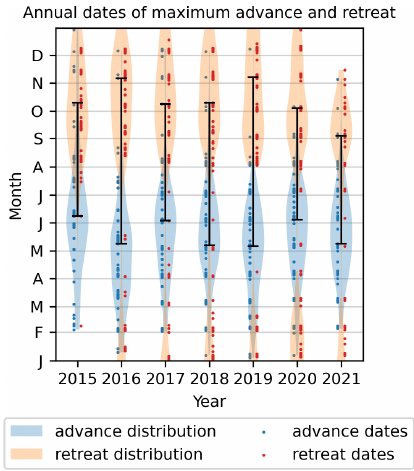
Figure 3. Distribution of the annual timing of maximum terminus- position advance (blue) and maximum terminus-position retreat (or- ange) for all seasonally varying glaciers in the study. The width of the shaded region represents the likelihood that maximum advance (blue) or retreat (orange) will occur on a given date. The vertical black bars show the duration of the retreat period each year, and the horizontal lines at the end of the vertical bars show the median date of maximum advance (in the blue region) or retreat (in the orange region) for each year. Dots show the dates of maximum advance (in blue, to the left) or maximum retreat (in orange, to the right) for in- dividual glaciers each year. Retreat timing distributions in the early months of a year are continuations of the retreat timing distributions from the previous year. Table 2. Annual breakdown of the magnitude and timing of terminus-position seasonality across all seasonally varying